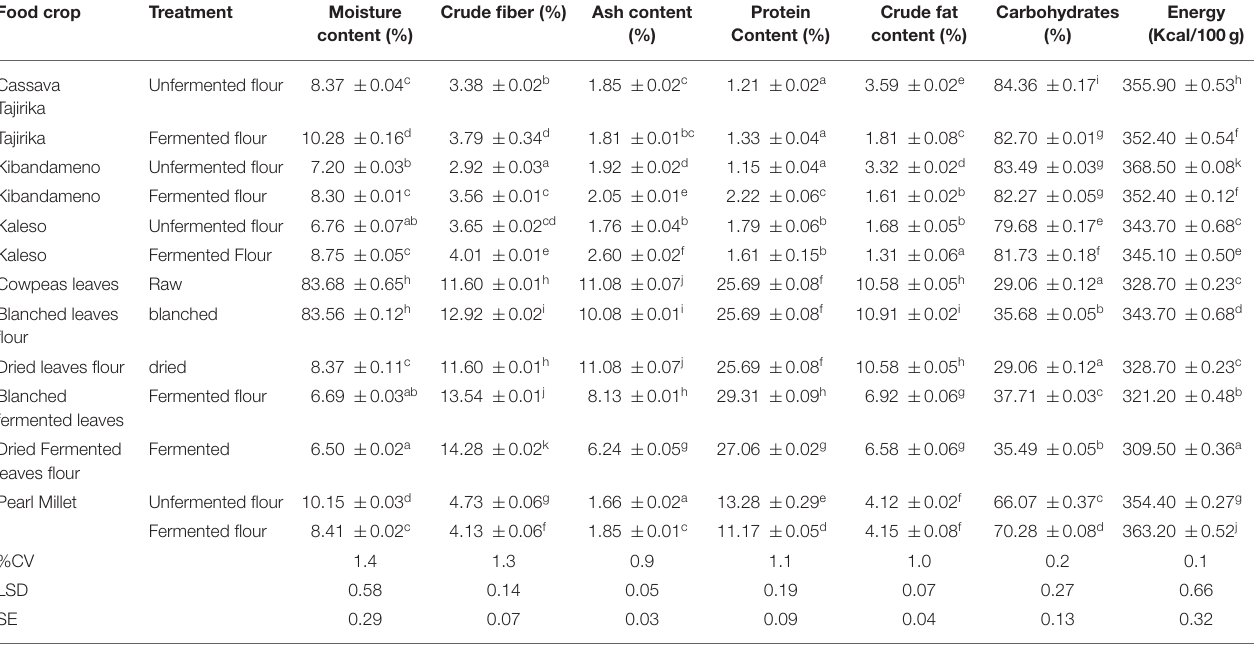
TABLE 1 | Proximate composition of unfermented flours and fermented flours of cassava roots, cowpea leaves, and pearl millet. Food